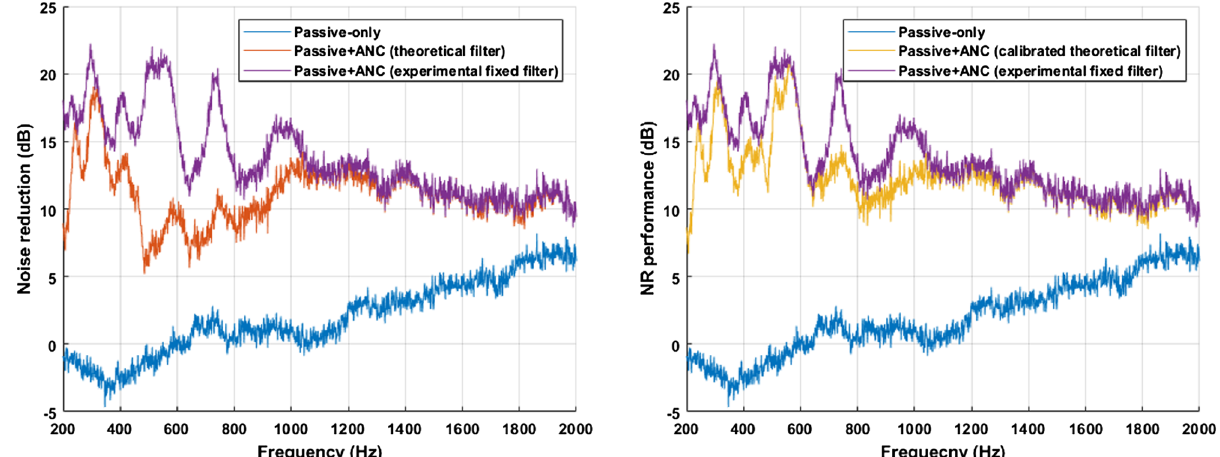
Figure 11. Noise reduction in the experiment: through the barrier only (blue), circular active noise barrier based on model 2 (red), circular active noise barrier using the calibrated theoretical control filter based on the preliminary experiment (yellow), and circular active noise barrier using the Wiener filter solution (purple).